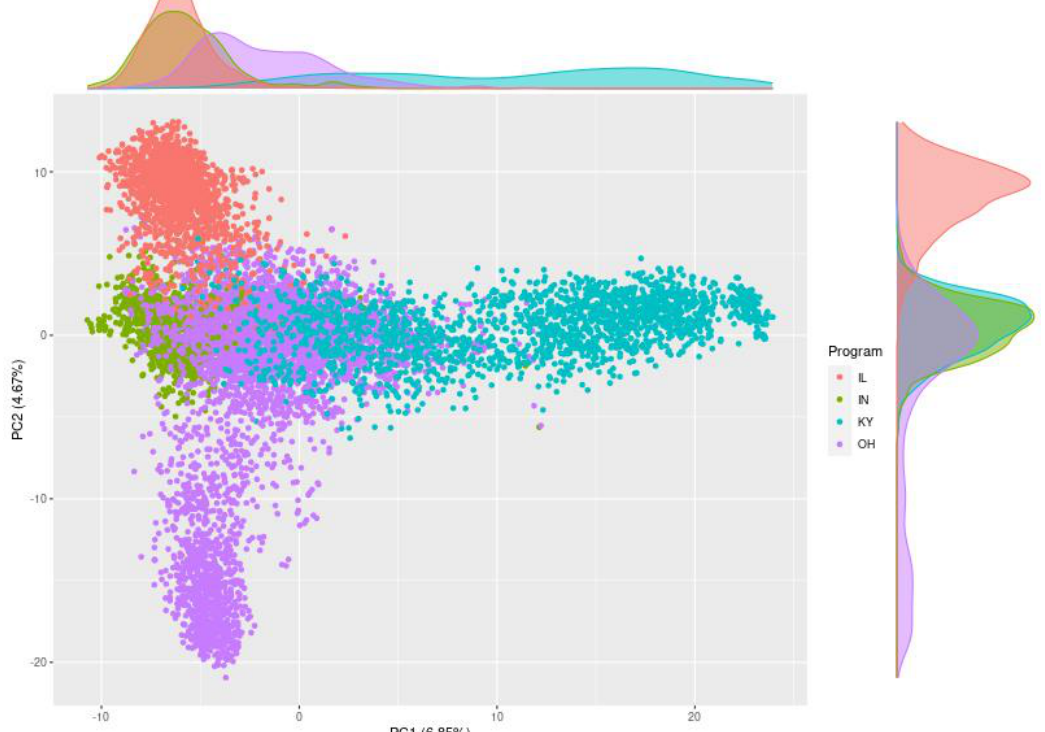
Figure 3. Graph of first two principal components (PC) from analysis of 6399 genetic mar17ers on 8943 winter wheat germplasm accessions from the four consortium breeding programs. Graphs along the top and right side show the distribution along the axes of accessions from the four programs.